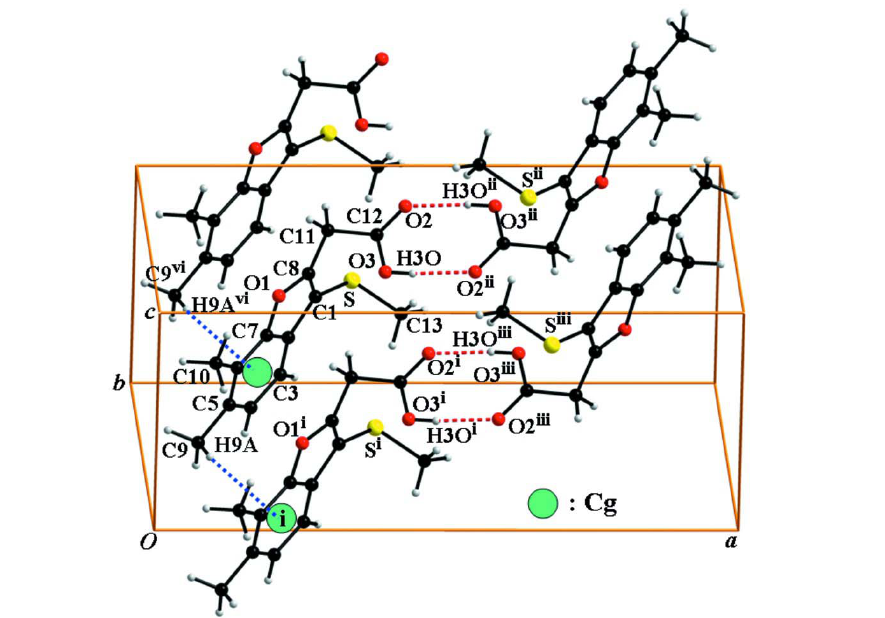
Figure 2 C—H··· π interactions and hydrogen bonds (dotted lines) in (I). Cg denotes the ring centroid. [Symmetry code: (i) x , y - 1, z ; (ii) - x + 1, - y + 1, - z + 2; (iii) - x + 1, - y , - z + 2; (iv) x , y + 1, z